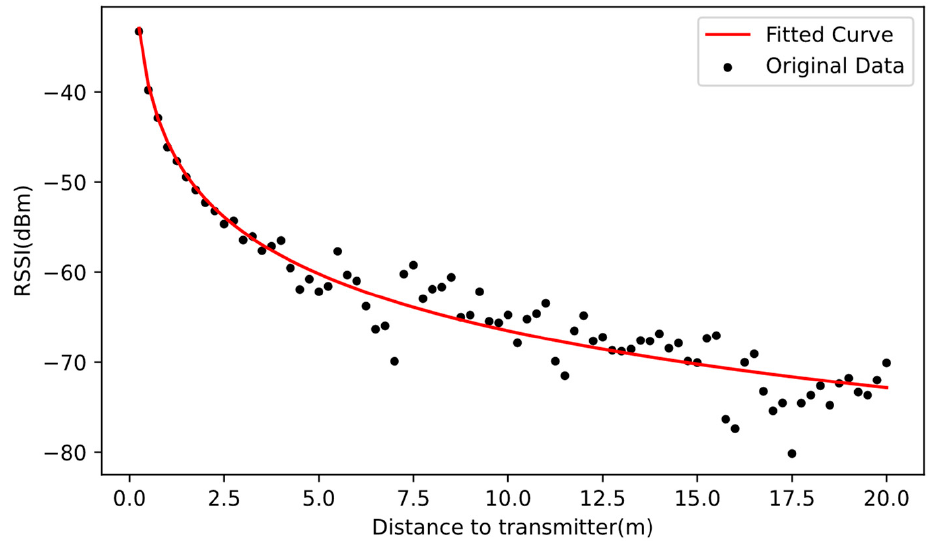
Figure 5. Fitted curve of BLE ranging model.